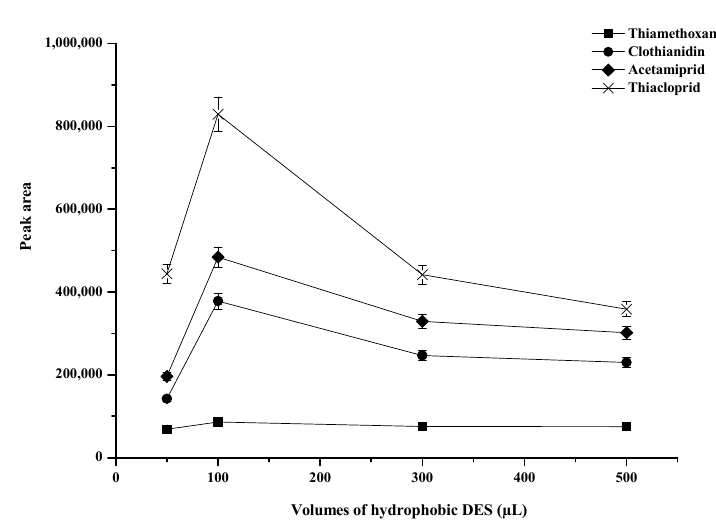
Figure 2. Effect of the volume of hydrophobic DES. Conditions: 400 µL of ACN; 10 mmol·L − 1 of SDS; vortex time 30 s; centrifugation time at 5000 rpm for 10 min (sample volume 10 mL, 0.5 µg·mL − 1 of each neonicotinoid insecticide).